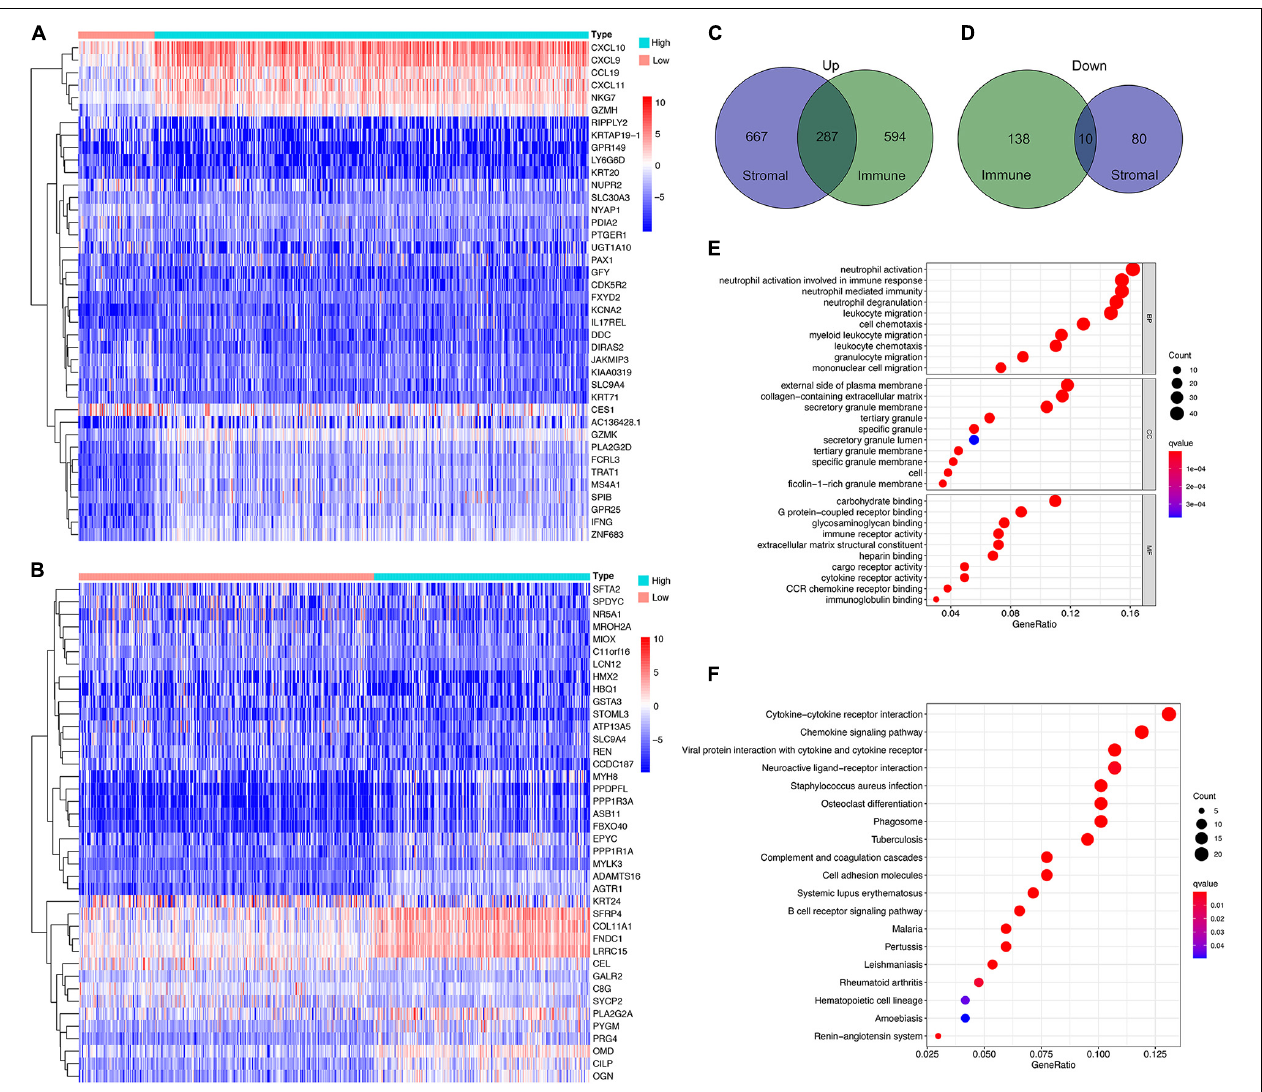
FIGURE 2 | Profile of differential expressed genes (DEG)s and functional enrichment analysis based on the stromal and immune scores. (A,B) Heatmap for DEGs generated by comparing the high score with low score group for Immune Scores and Stromal Scores. The row name of the heatmaps is the gene name. (C,D) Common up-regulated, and down-regulated DEGs shared by Immune Score and Stromal Score in the Venn plots. (E,F) GO and KEGG enrichment analysis for DEGs.